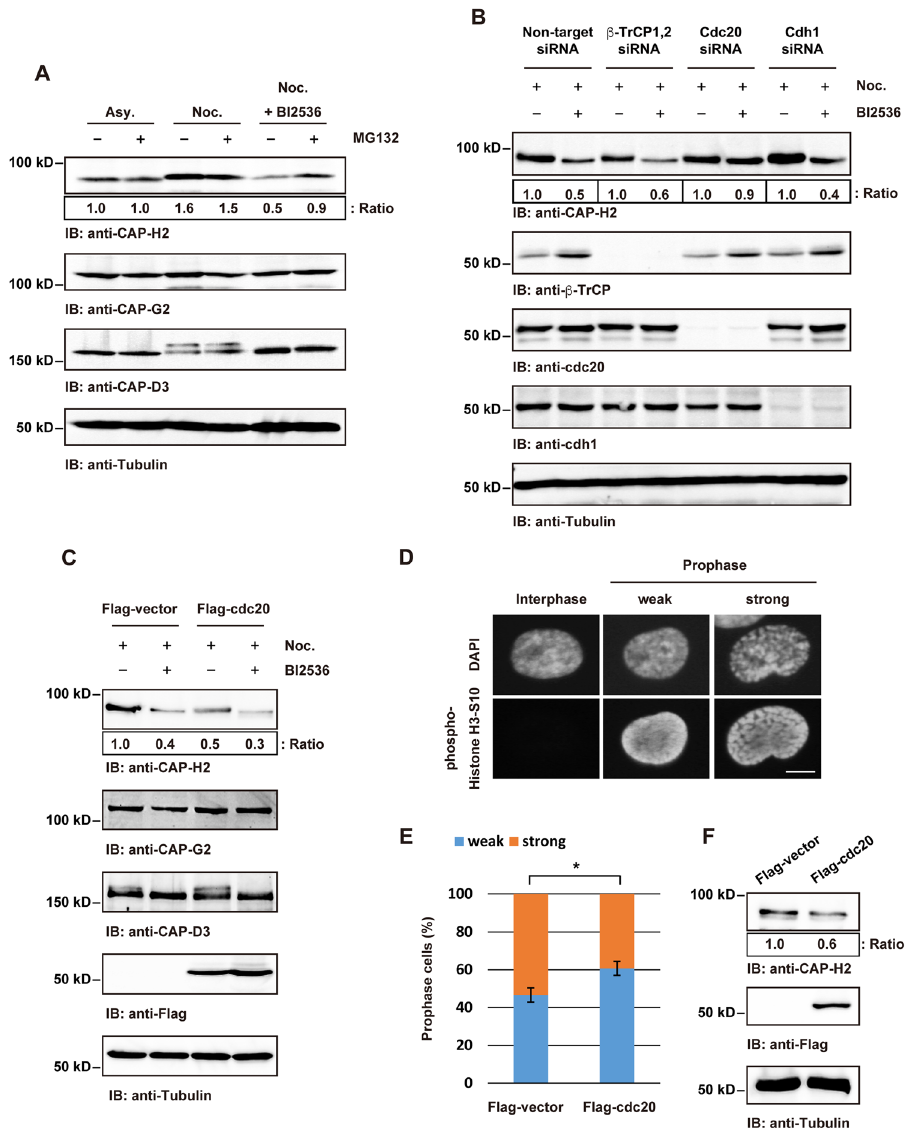
Figure 3. Cdc20 regulates condensin II function by degradation of CAP-H2 during mitosis. ( A ) HeLa cells were synchronized at mitosis by nocodazole with or without BI2536, and then the cells were treated with MG132. Cell lysates were analyzed by immunoblotting with indicating antibodies. A ratio of CAP-H2/Tubulin was determined by the densitometric analysis using Fusion-CAPT-Software. The ratio of CAP-H2/Tubulin in untreated cells was defined as 1.0. ( B ) HeLa cells were transfected with non-target siRNA, β -TrCP1/2 siRNA, Cdc20 siRNA or Cdh1 siRNA. At 24 h after transfection, cells were treated with nocodazole and BI2536 for 16 h. Mitotic cell lysates were immunoblotted with the indicated antibodies. A ratio of CAP-H2/Tubulin was determined by the densitometric analysis using Fusion-CAPT-Software. The ratio of CAP-H2/Tubulin in each of siRNA transfected and nocodazole treated cells was defined as 1.0. ( C ) HeLa cells were transfected with Flag-vector or Flag-Cdc20. At 24 h after transfection, cells were treated with nocodazole and BI2536 for 16 h. Mitotic cell lysates were immunoblotted with the indicated antibodies. A ratio of CAP-H2/Tubulin was determined by the densitometric analysis using Fusion-CAPT-Software. The ratio of CAP-H2/Tubulin in Flag-vector transfected and nocodazole treated cells was defined as 1.0. ( D ) Fixed HeLa cells were stained with anti-phospho-histone H3-Ser10. DNA was stained by DAPI. Degrees of prophase chromosome condensation were defined in the two categories and the representative cells are shown. Scale bar, 10 μ m. ( E ) HeLa cells were transfected with Flag-vector or Flag-Cdc20 and synchronized at G1/S phase by thymidine treatment. Cells were then released into the cell cycle. At 9 h after release, cells were fixed and were stained with anti-phospho-histone H3-Ser10 and anti-Flag. The percentage of each category, defined in D, was calculated. n > 100 cells per indicated condition were analyzed. Data represent mean ± SD from three independent experiments. Statistical analysis was performed with the Student’s t test ( * P < 0.05). ( F ) The cells were transfected and synchronized as described in E. Cell lysates were analyzed by immunoblot analysis using indicated antibodies. A ratio of CAP-H2/Tubulin was determined by the densitometric analysis using Fusion-CAPT- Software. The ratio of CAP-H2/Tubulin in Flag-vector transfected cells was defined as